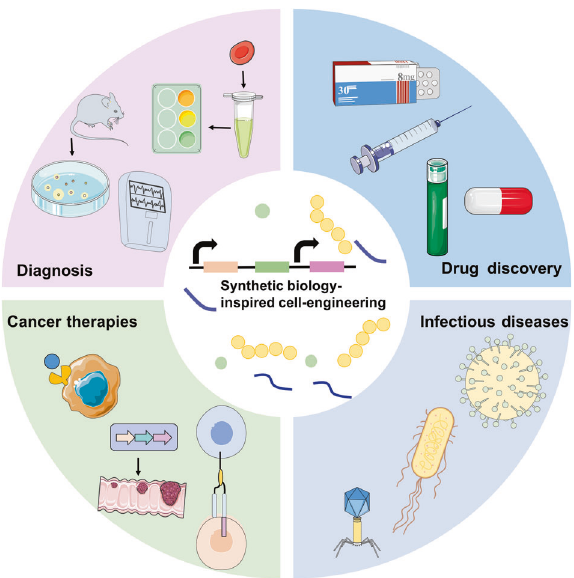
Fig. 1 Synthetic biology-inspired cell engineering can be employed for various medical applications. Synthetic gene networks are uploaded into cells for disease diagnosis, cancer therapies, infectious diseases treatment, and drug